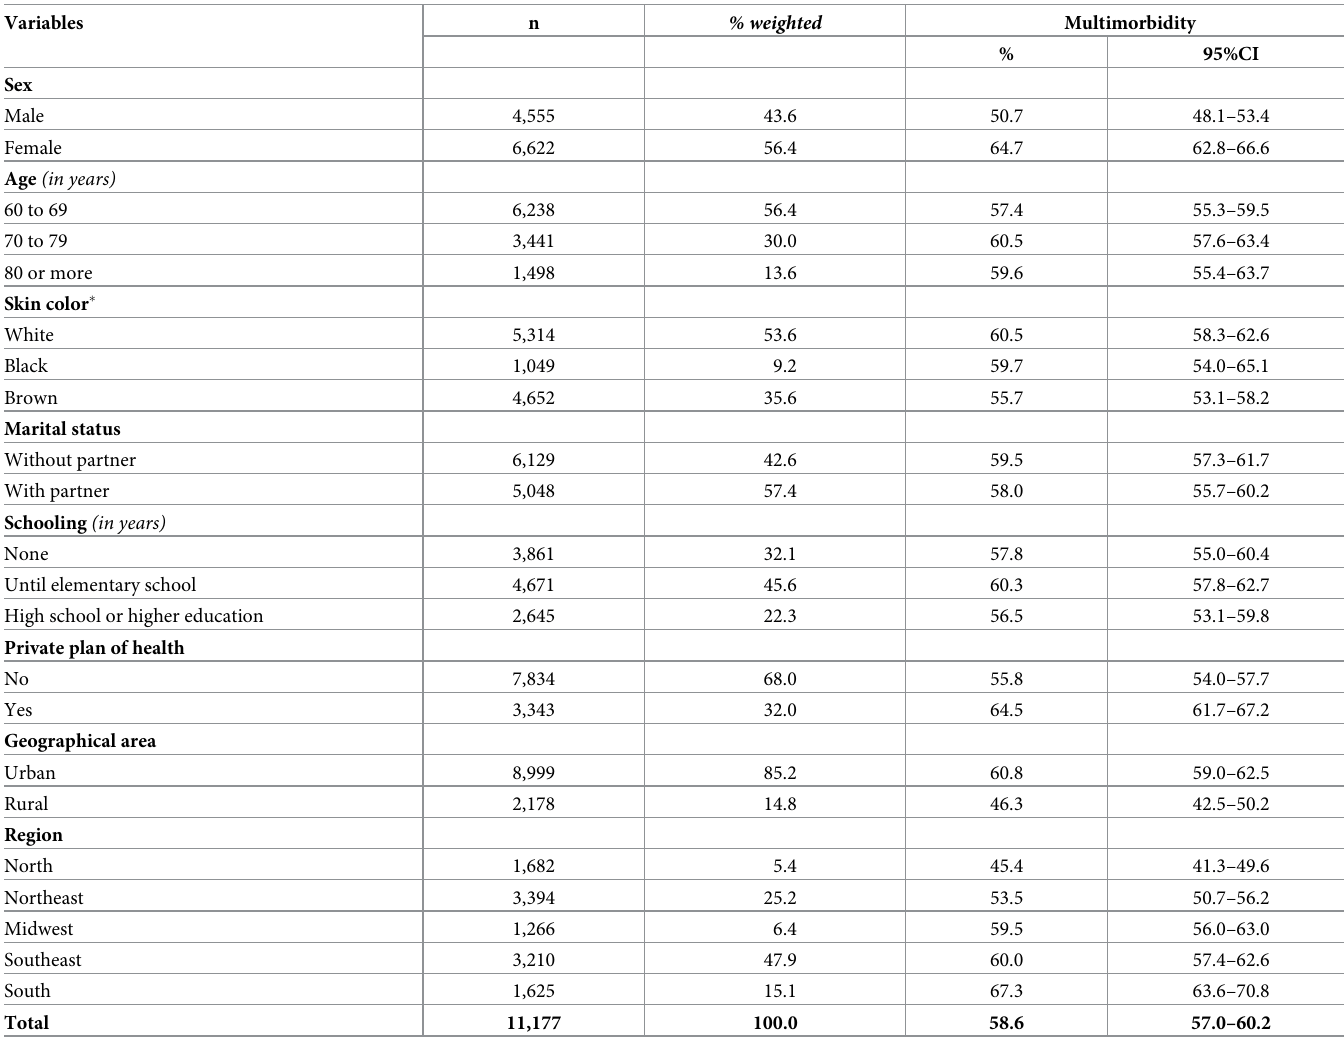
� Yellow and indigenous accounted for 1.6% of the sample.